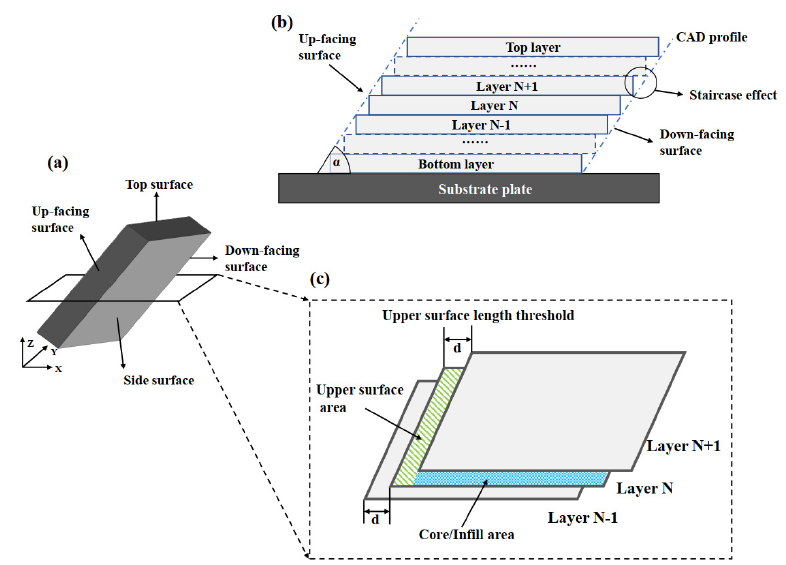
Figure 1. Schematic figure of ( a ) typical faces of LPBF sample, ( b ) staircase effect in LPBF process, and ( c ) the definition of up-facing skin as indicated by green line infill, for layer N.